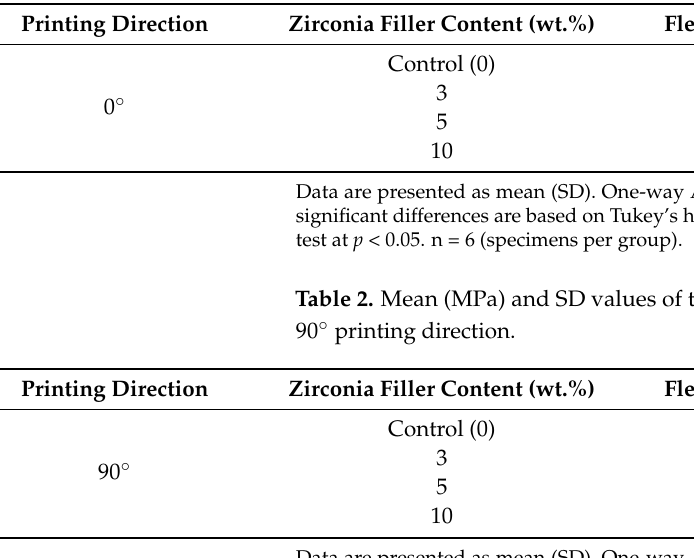
Table 1. Mean (MPa) and standard deviation (SD) values of the flexural strengths and moduli for the test groups in the 0 ◦ printing direction.